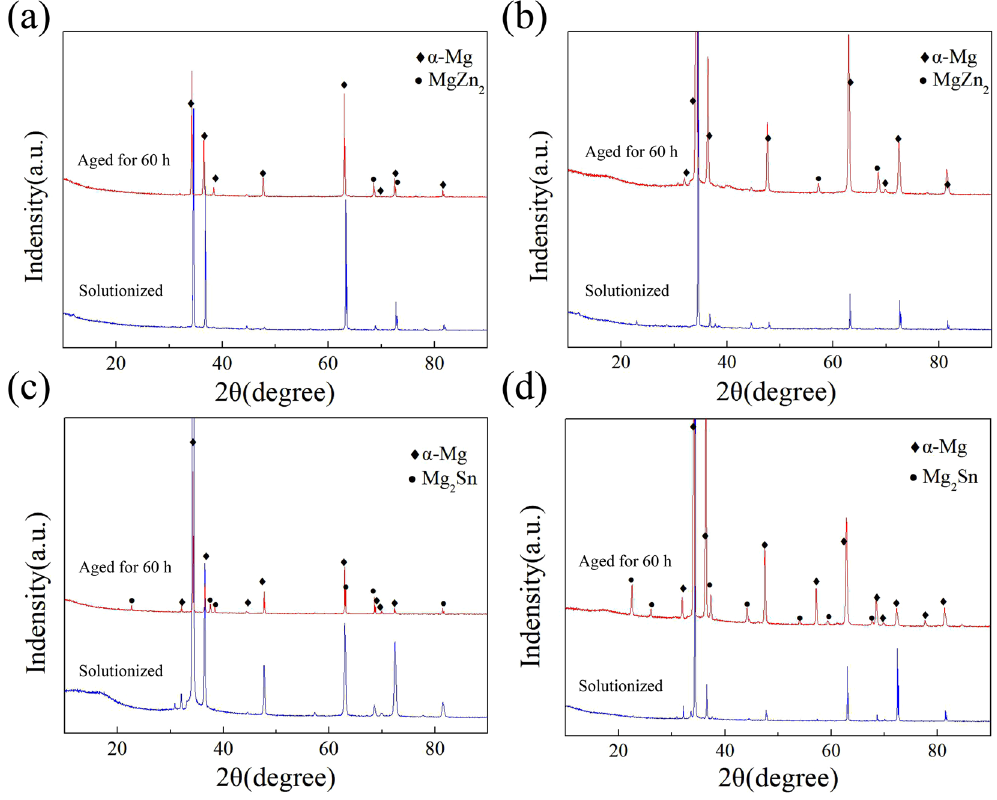
Figure 5. XRD patterns of solutionized and aged for 60 h after rolling ( a ) Mg-3Zn, ( b ) Mg-5Zn, ( c ) Mg-3Sn, and ( d ) Mg-5Sn